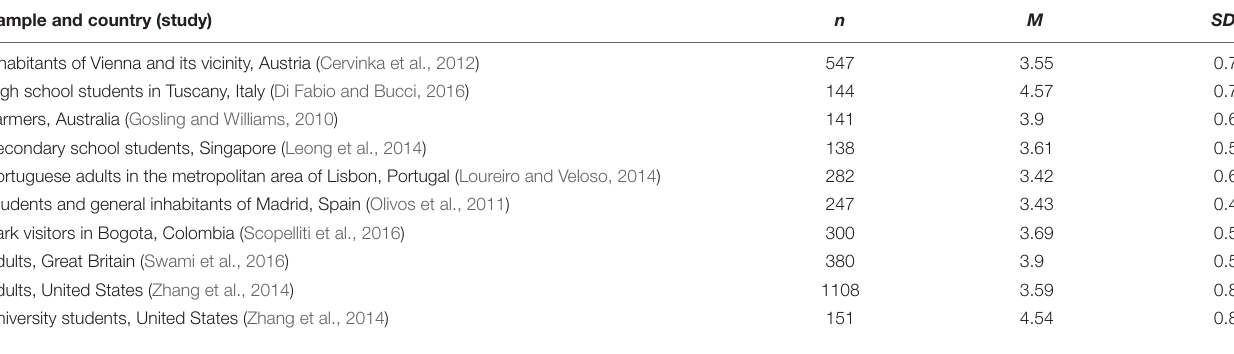
TABLE 1 | Mean connectedness to nature in selected populations measured with the Connectedness to Nature Scale (Mayer and Frantz, 2004) on a five point Likert scale. Sample and country